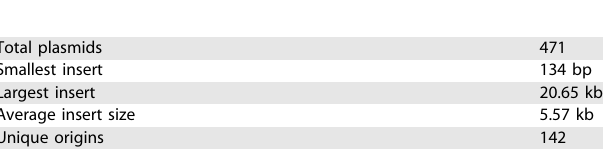
Table 1. Relevant Statistics on Plasmids Isolated from Both Wild- Type and mcm1–1 Cells